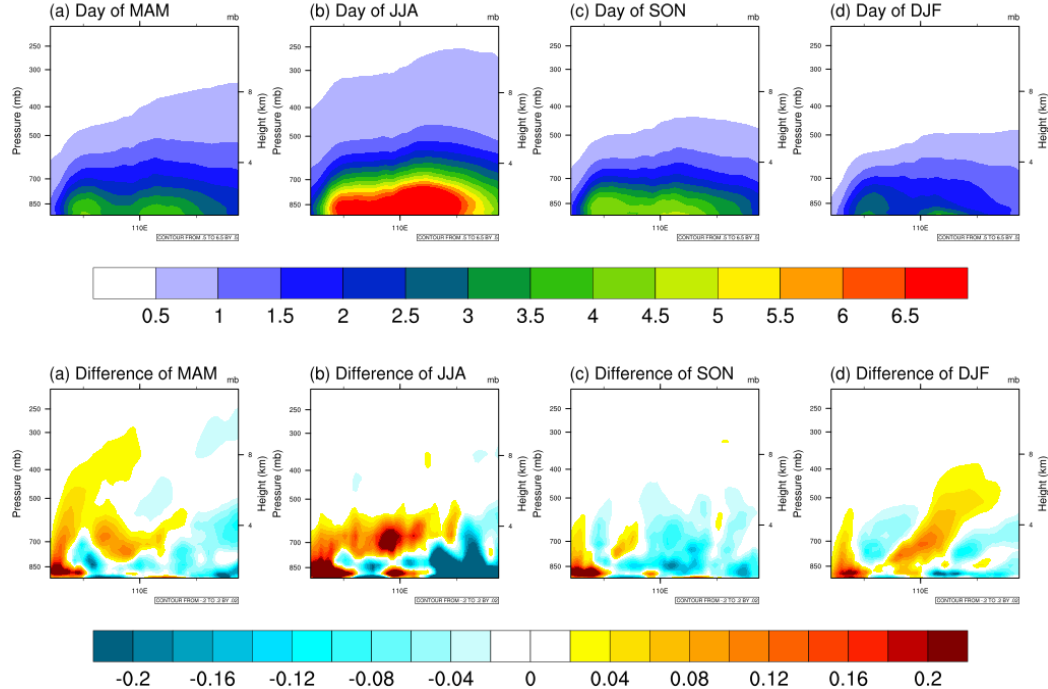
Figure 9. Vertical distributions of seasonal average sulfate aerosol concentrations ( µ g kg − 1 ) in eastern China (24–43 ◦ N, 101–126 ◦ E) during the daytime ( top ) and the difference between daytime and nighttime ( bottom ) in different seasons of 2010.